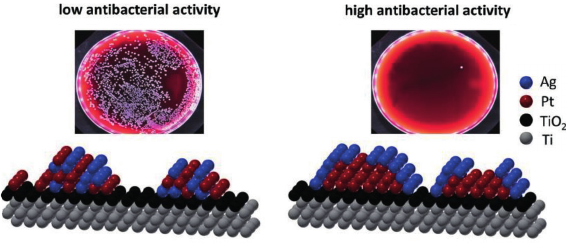
Figure 2 Antibacterial activity of silver and platinum particles